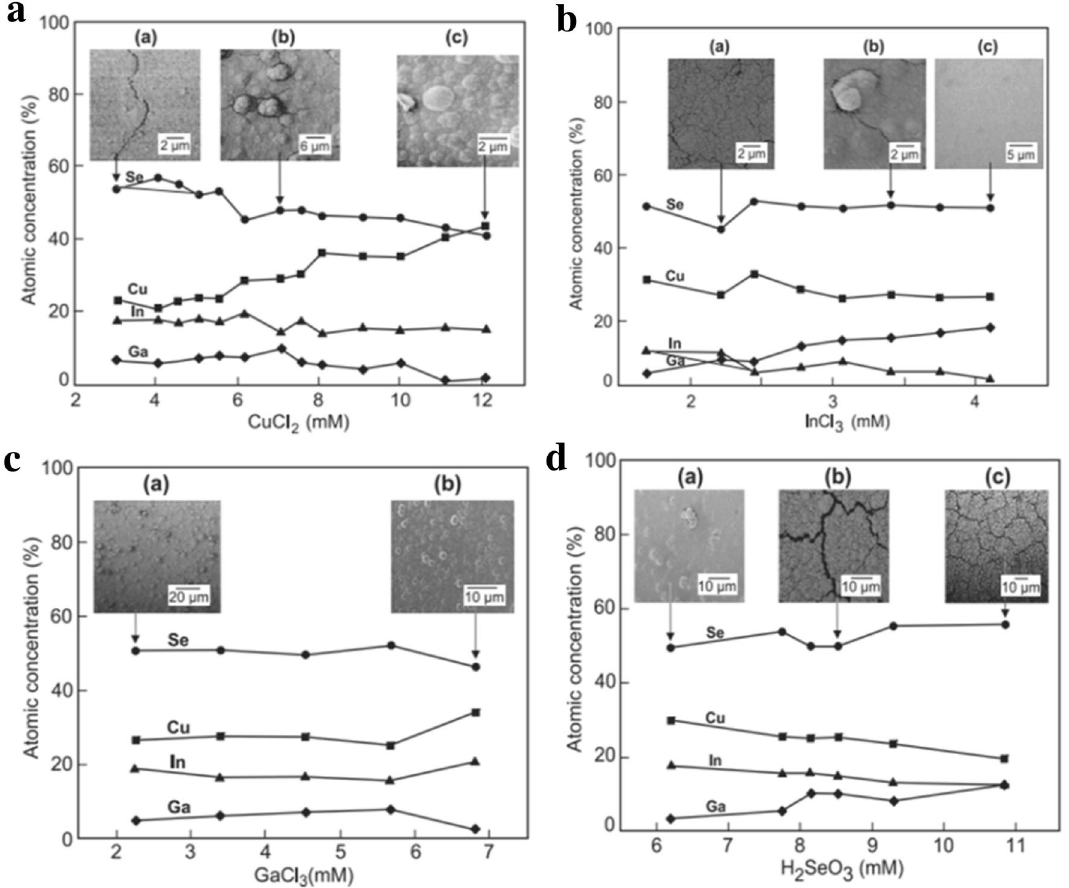
Fig. 8 Composition variation of CIGSe as a function of Cu, In, Ga and Se ions concentration. Reprinted from Fernandez et al. [84]. Copyright (2003) with permission from